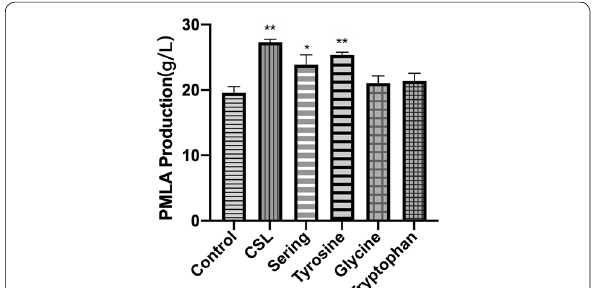
Fig. 6 Different amino acids on PMLA production ( * P < 0.05, ** P < 0.01 versus the control group by the LSD